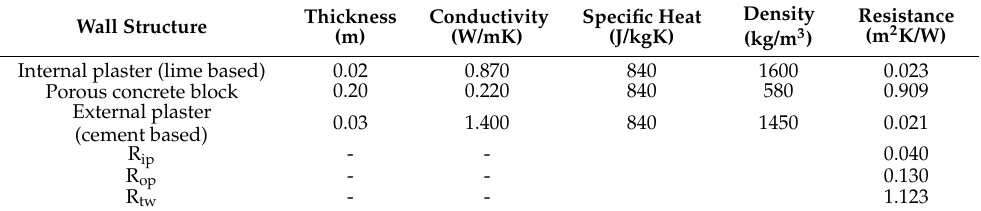
Table 1. Physical properties of the external wall in the study area